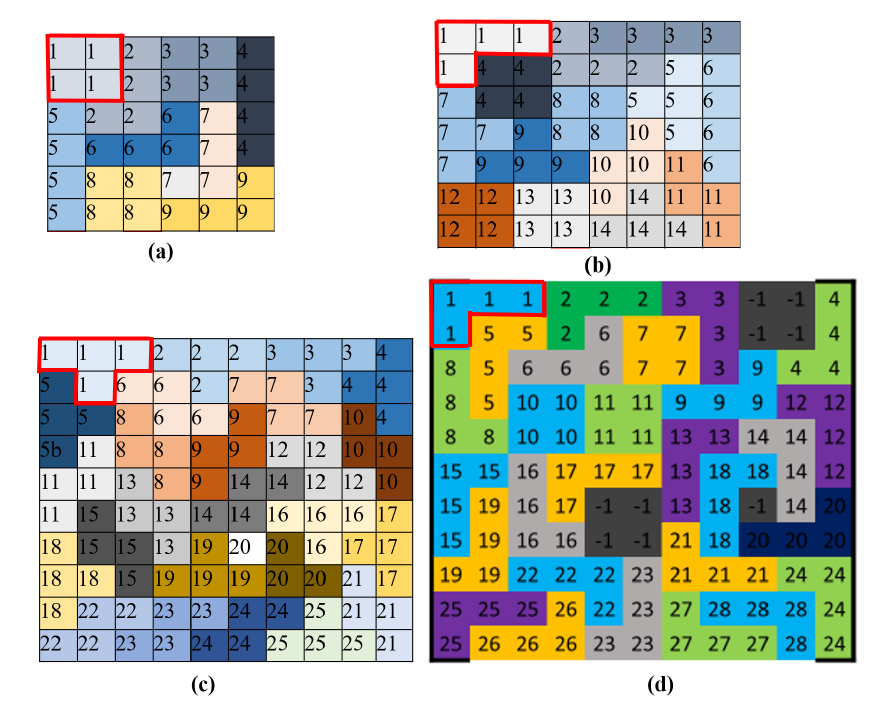
Figure 12. Generated tileset for tested workspaces. ( a ) 6 × 6 workspace; ( b ) 8 × 7 workspace; ( c ) 10 × 10 workspace; ( d ) 11 × 11 workspace with obstacles.